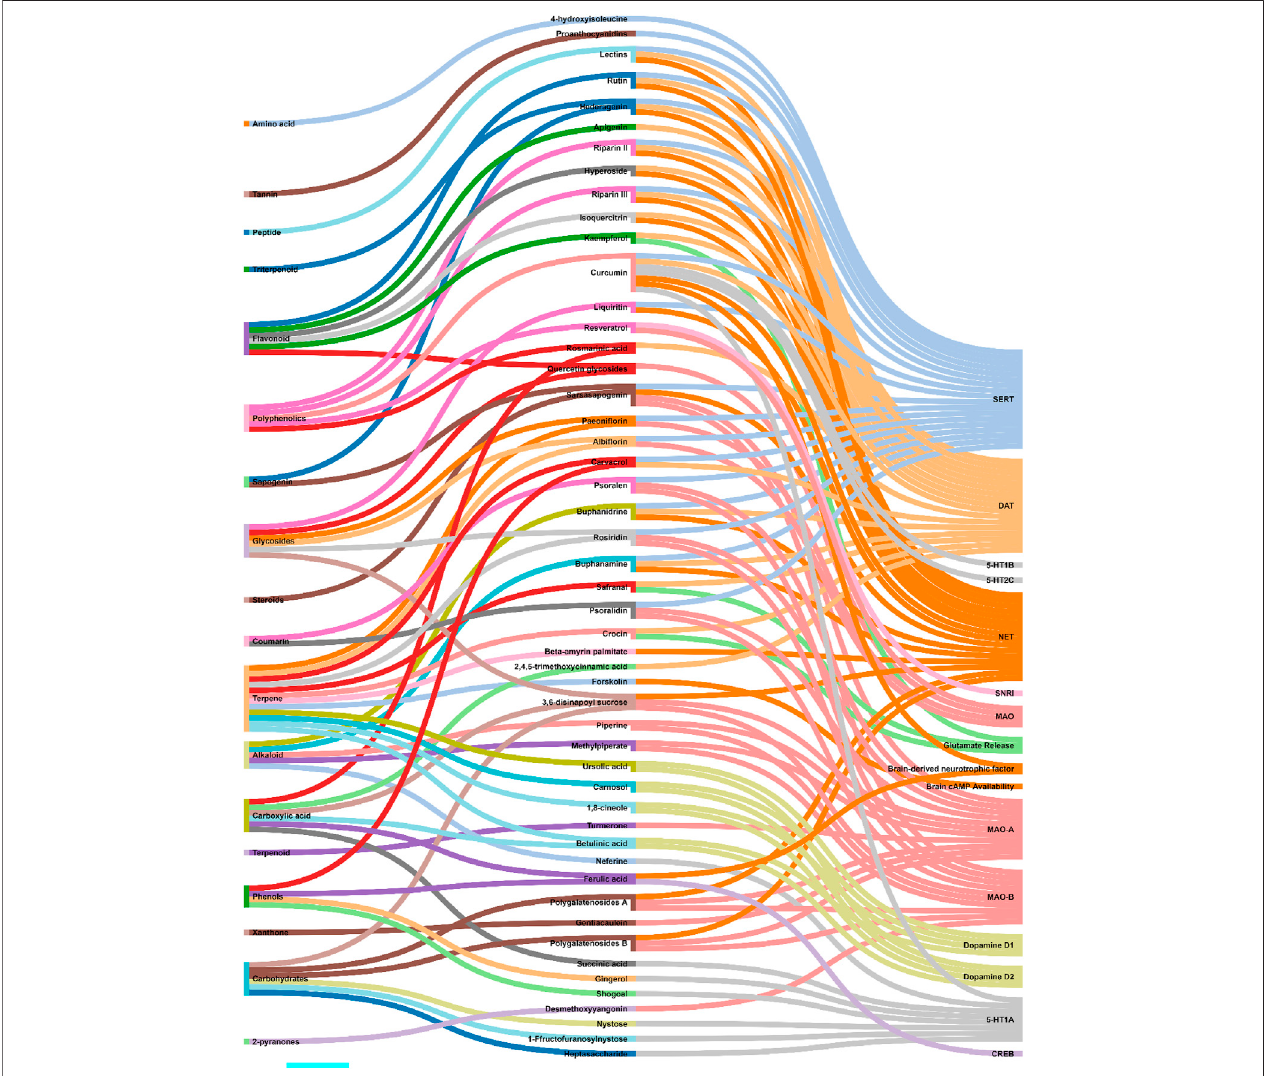
FIGURE 4 | Interaction analysis map to express association and relationship between phytochemical classi fi cations of antidepressant metabolites with the physiological pathways related to depression.